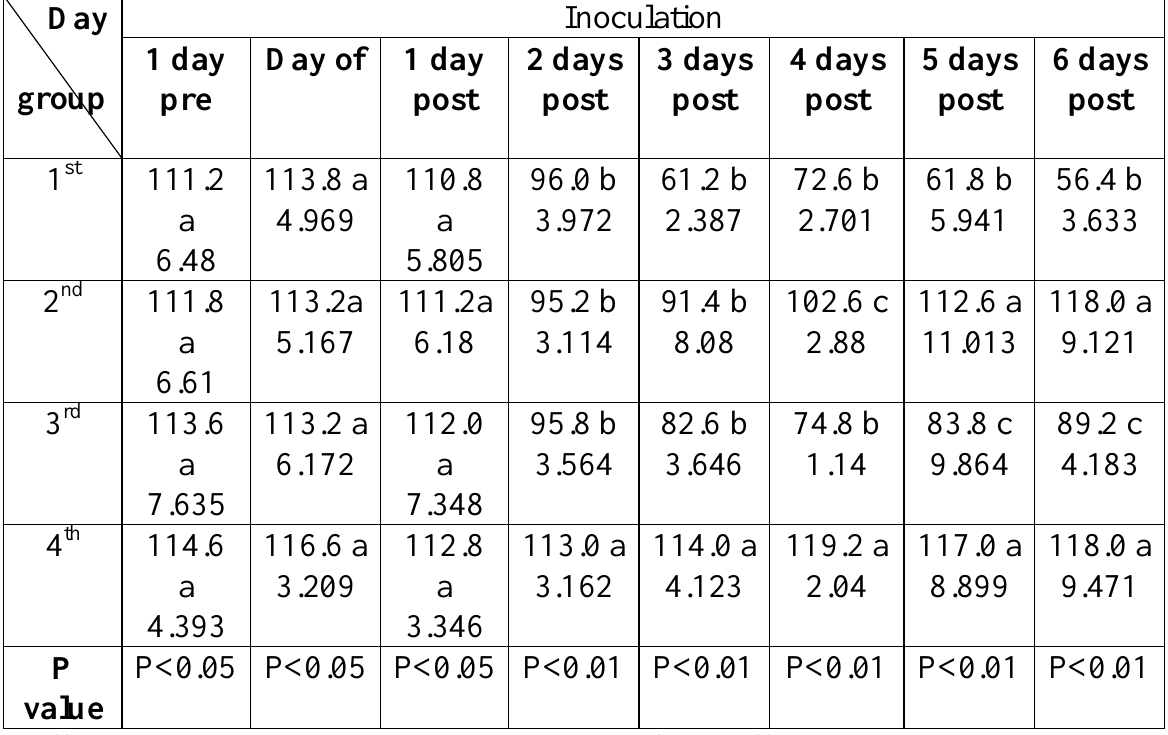
Table (5) Means ±SE. of serum chloride concentration by mmol/L in different